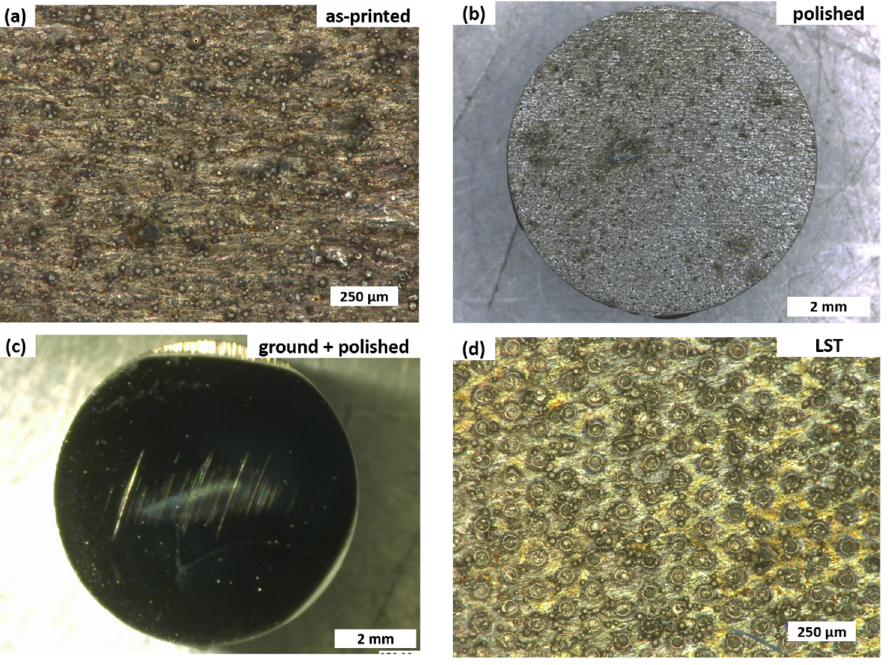
Figure 4. Optical micrographs for samples after tribological experiments. ( a ) As-printed, ( b ) polished, ( c ) ground and polished, and ( d ) laser-surface-textured H13 steel samples initially prepared by SLM. Magnification for each image was chosen as such to best represent the samples.